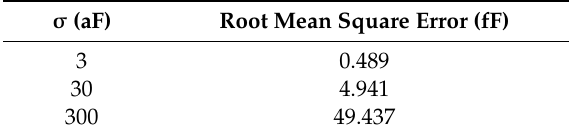
Table 5. Root mean square errors of fitting results under different measurement noise.